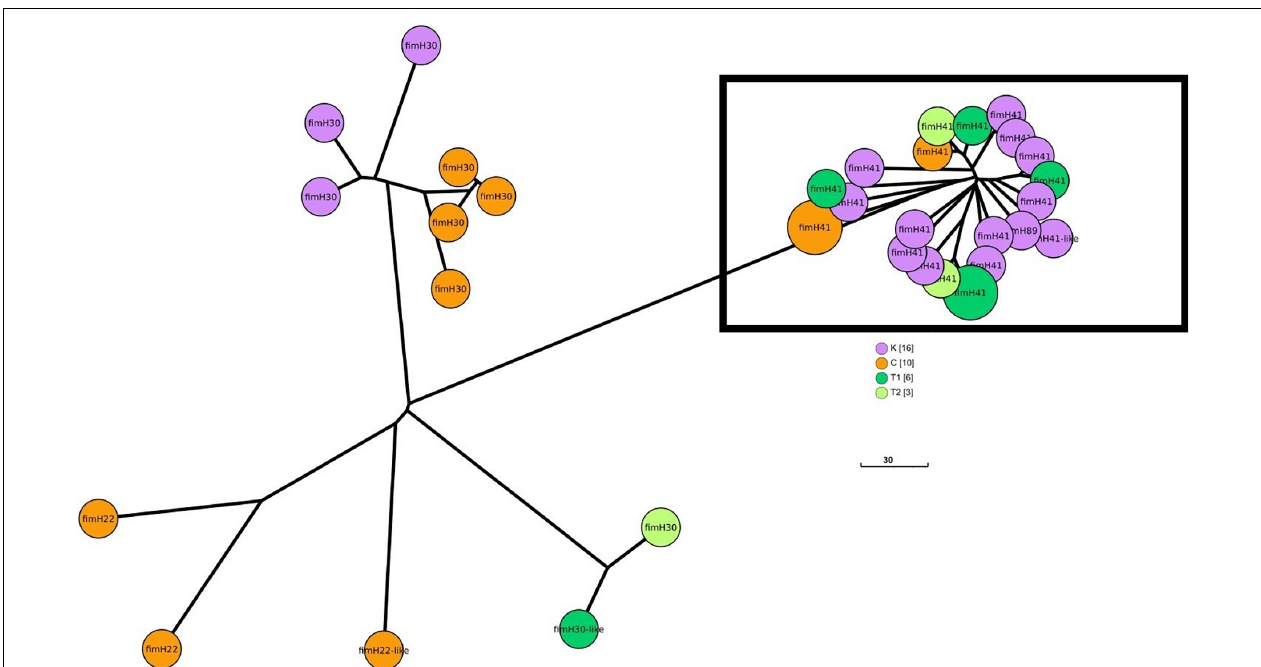
FIGURE 4 | GrapeTree minimum-spanning tree based on the Enterobase cgMLST from different areas in southern Taiwan (C, Chiayi; K, Kaohsiung; T1, city center, Tainan; T2, rural area, Tainan). The largest cluster is marked with a